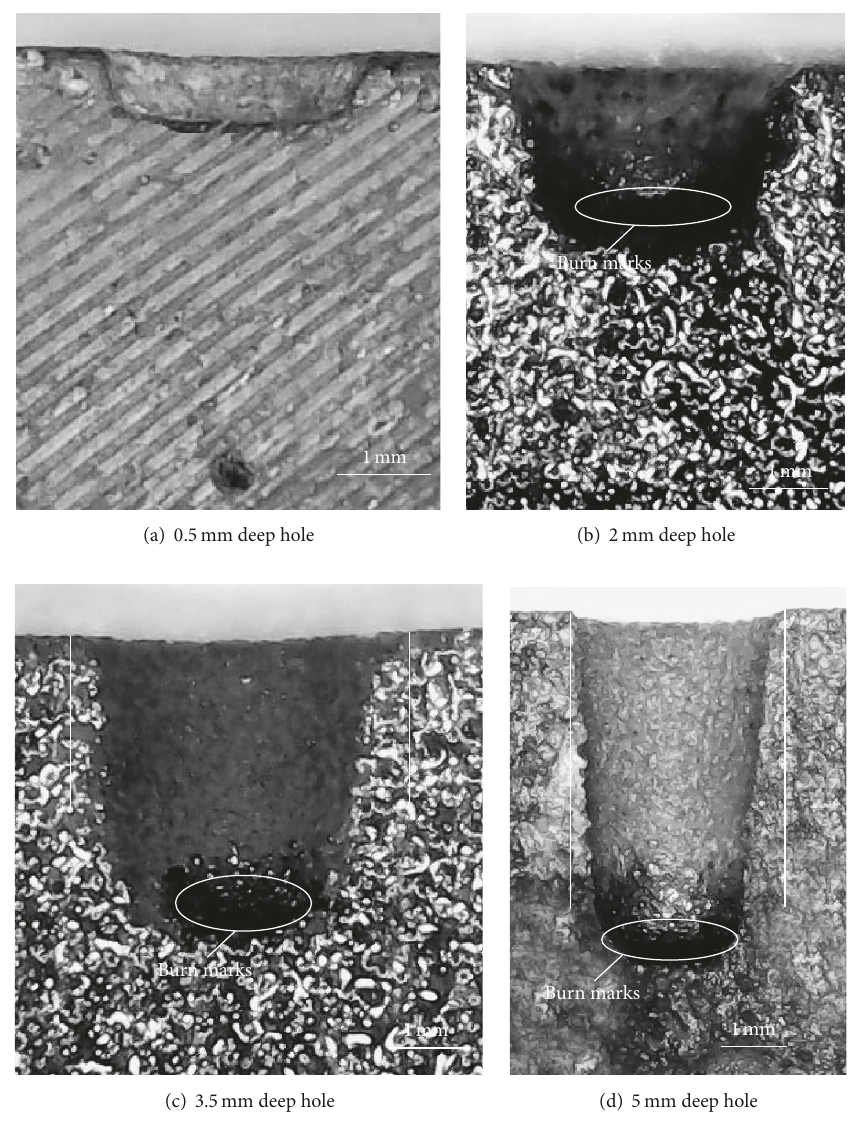
Figure 25: The cross section image of machined holes with